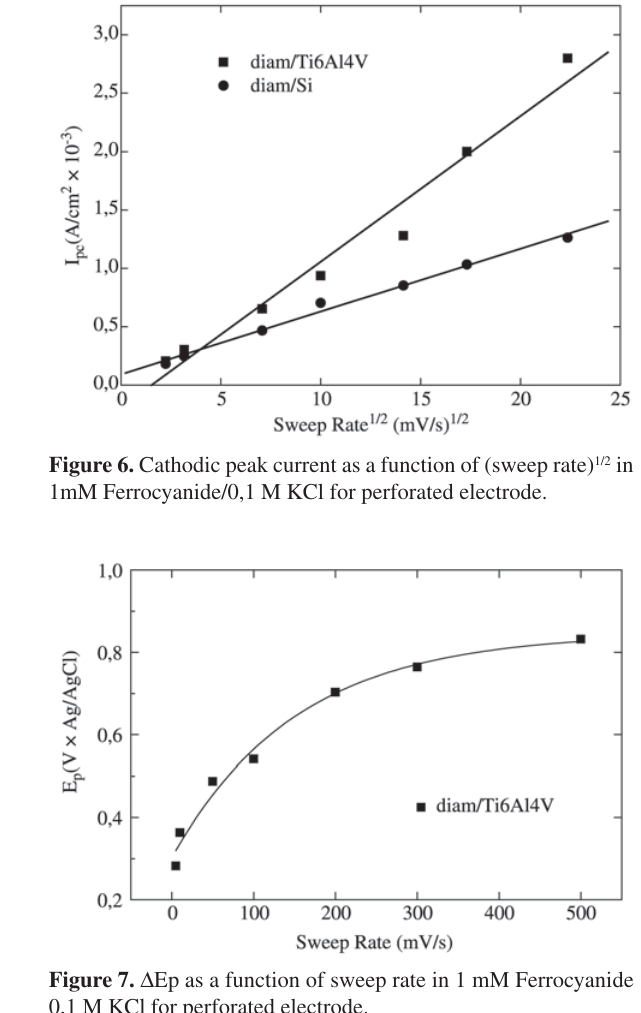
Figure 5. Current density in 0,1 M neutral